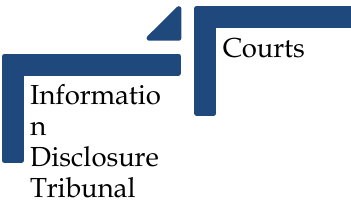
Figure 7: Levels of RTI Appeals in Thailand